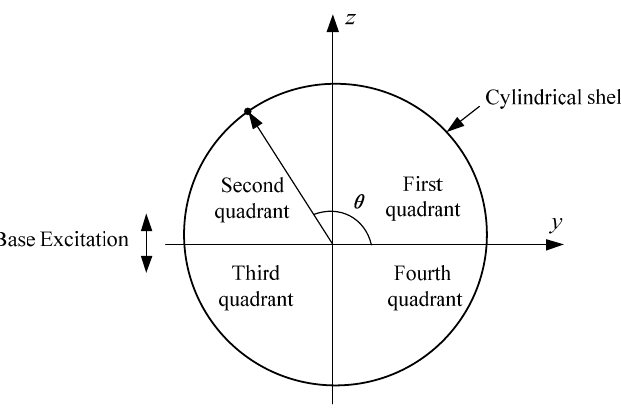
Table 1. Geometrical parameters of the hard ‐ coating cylindrical shell. Parameters